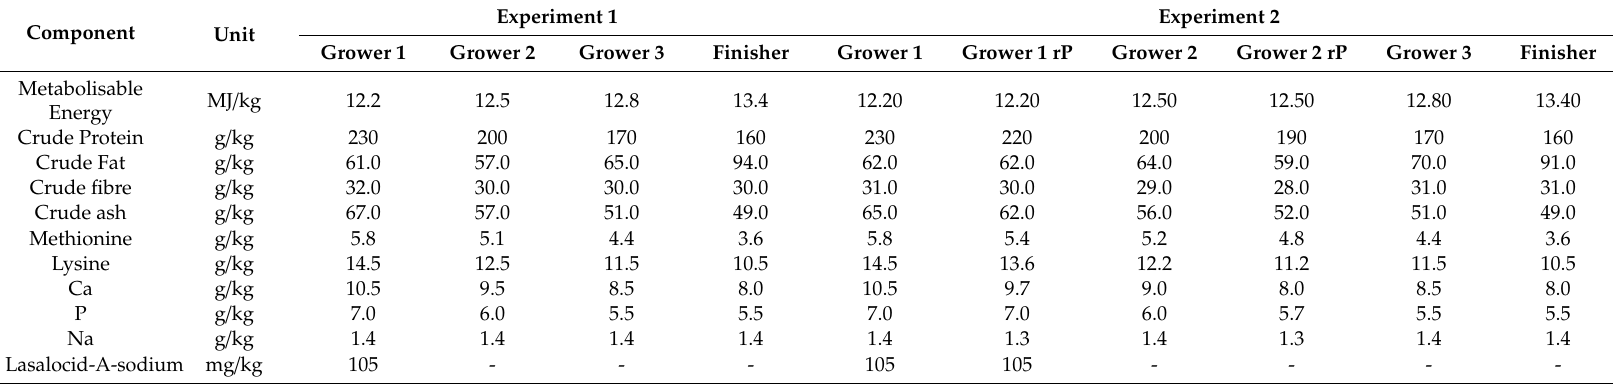
Table 1. Nutrient content of the standard and reduced crude protein (rP) diets provided by the feed company for the grower and finisher feeds used in Experiments 1 and 2 for fattening the turkey toms.